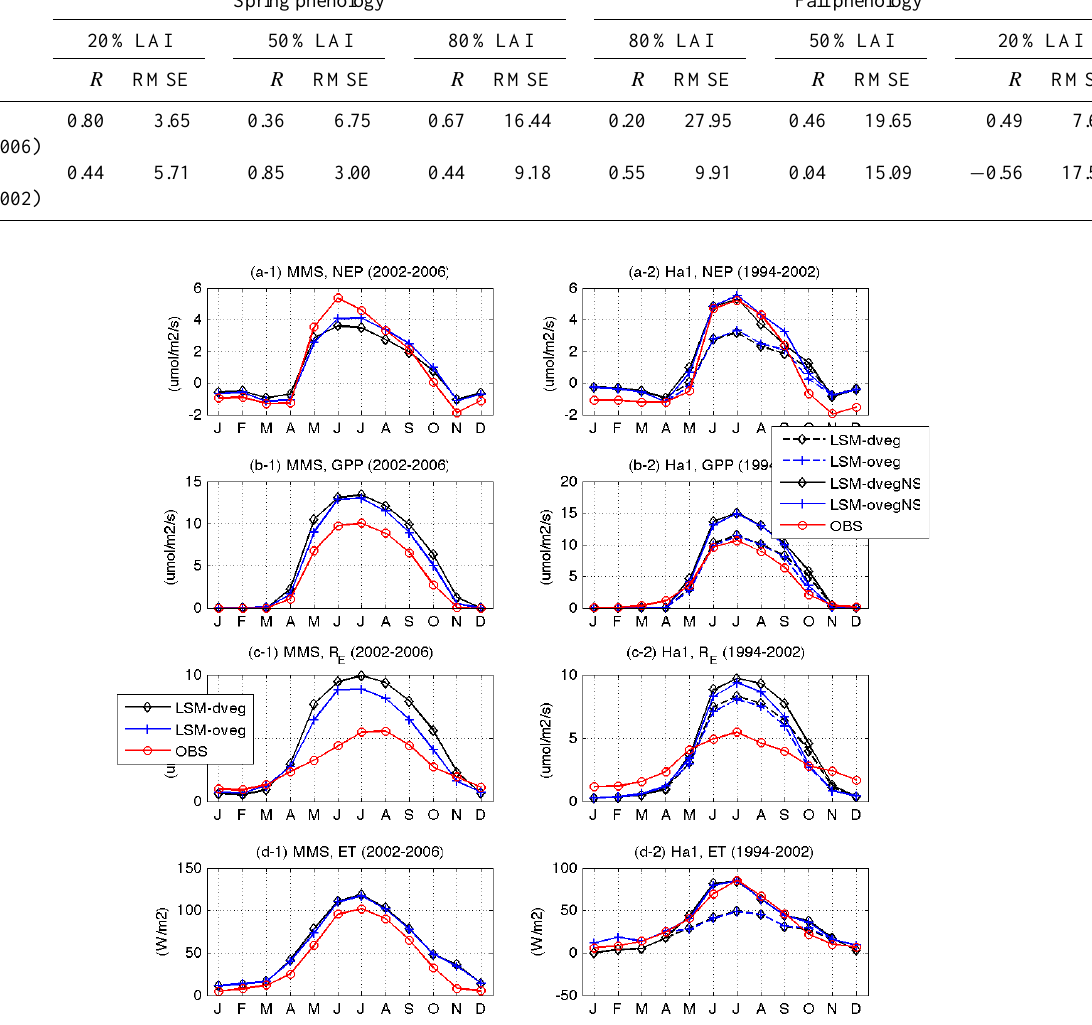
Table 5. Correlation coefficients and RMSEs of LAI-based phenological dates between simulations and observations. Site Spring phenology Fall phenology